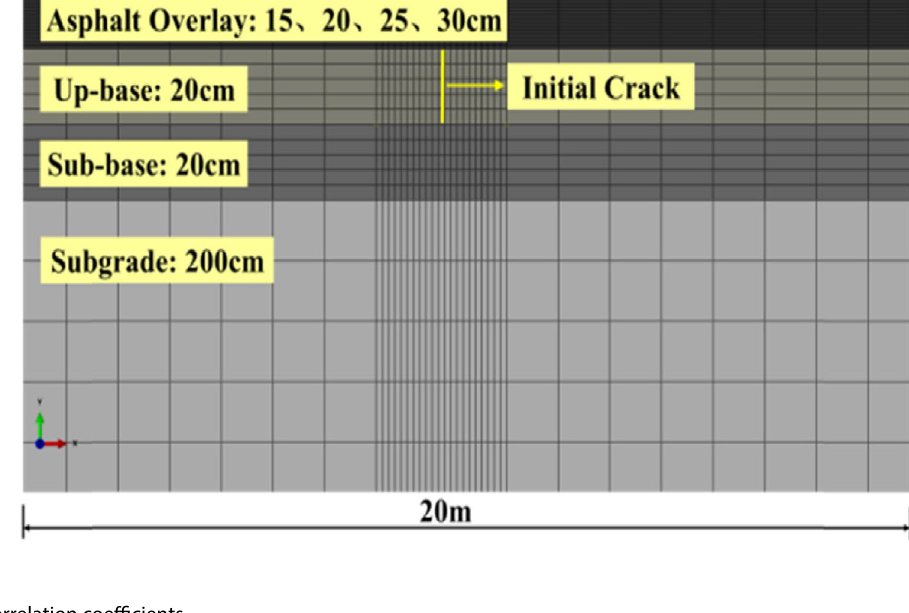
Fig. 2 Asphalt pavement models